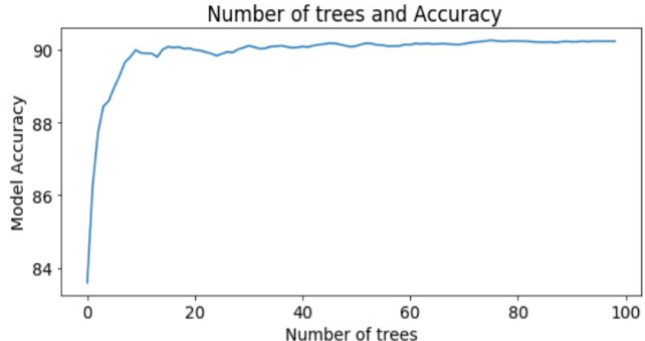
Figure 6. Number of trees vs. test accuracy of the random forest algorithm.